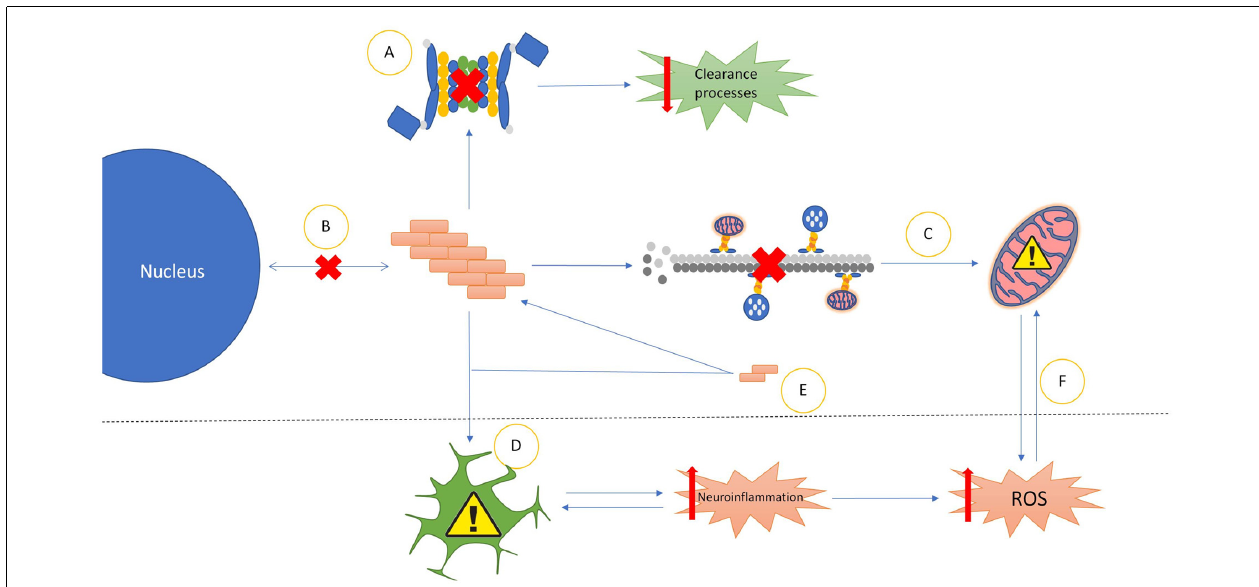
FIGURE 1 | Common properties of prionoid disease pathways. (A) Most prionoid proteins have been associated with inhibition of the cell’s autophagic machinery, particularly the lysosomal autophagy and ubiquitin-proteasome systems. This results in inhibited cellular clearance processes, enabling greater accumulation of aggregates. (B) Aggregated proteins often mislocalize into aberrant cellular compartments. In amyotrophic lateral sclerosis (ALS), TAR DNA-binding protein 43 (TDP-43) and fused in sarcoma (FUS) mislocalize from the nucleus to the cytoplasm. Amyloid- β in Alzheimer’s diseases (AD), α -synuclein in Parkinson’s disease (PD) and mutant superoxide dismutase-1 (mSOD1) in ALS mislocalize into the mitochondria. In Huntington’s disease (HD), Huntingtin (Htt) mislocalizes into the nucleus. (C) Many Neurodegenerative Disease (ND) processes involve the disruption of microtubule-mediated transport of various cellular components, particularly mitochondria. This often results in incorrect distribution of mitochondria, enhancing mitochondrial dysfunction. (D) Glial cells exert various neurotoxic and neuroprotective effects. In NDs these are often either insufficient to control pathological processes or subverted to enhance pathological spread or severity. The most common mechanism of this is increased neuroinflammatory activity, leading to the production of high levels of neurotoxic reactive oxygen species (ROS). The resultant oxidative injury enhances glial activation, compounding the effects of the pathology. (E) Soluble oligomeric species of prionoid proteins are often present in the cytoplasm of infected cells. While typically incapable of seeding aggregates, they are recruited to aggregates in order to accelerate their growth. There is evidence that oligomeric prionoids exert neurotoxic effects. Oligomers may contribute to the spread of pathology through uptake by microglia after being exocytosed. (F) Dysfunction in mitochondria leads to increased production of neurotoxic ROS. The downstream effects of ROS activity can damage mitochondria, resulting in a self-reinforcing